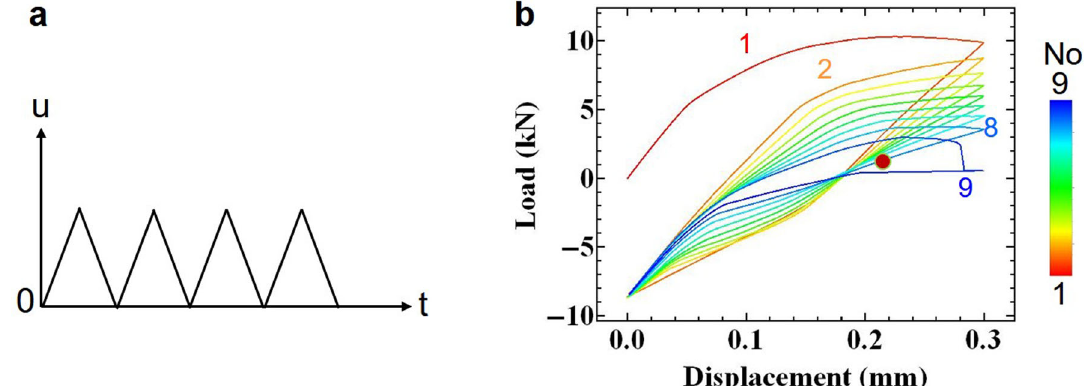
Fig. 6 Displacement and load evolution under cyclic loads. a Schematic for the evolution of the surface displacement. b Load-displacement curve with the displacement varying between 0.0 mm and 0.3 mm. The number and the color of the curve indicate the number of